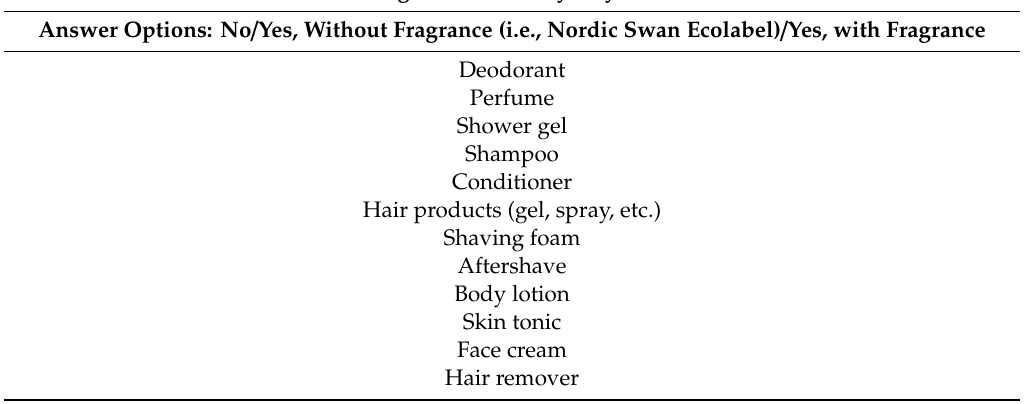
Table 1. Items used to assess aggregated PCP usage in the Fetal Programming of Semen Quality (FEPOS)